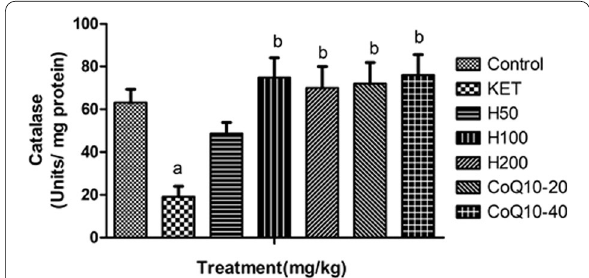
Fig. 8 Effect of hesperidin and Coenzyme Q10 on brain catalase levels in the hippocampus region of the brain. Data were analyzed by one-way ANOVA followed by Tukey’s post hoc analysis. All values were expressed as Mean SEM. a p < 0.05 as compared to naive, ± b p < 0.05 as compared to ketamine. KET, Ketamine; H, Hesperidin; CoQ10, Coenzyme Q10